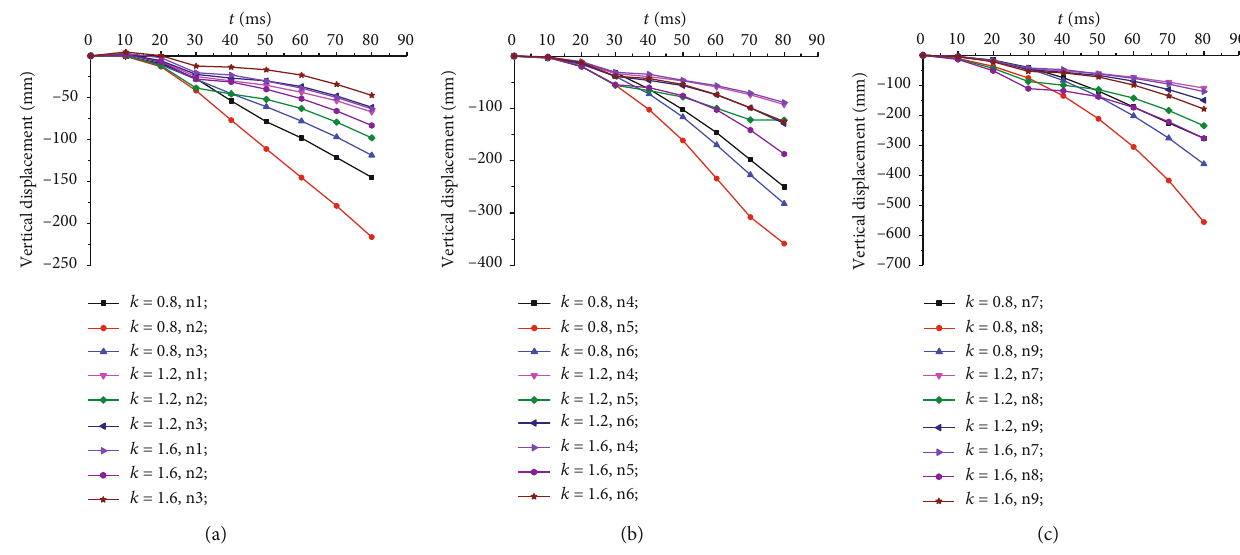
Figure 9: The vertical displacement at the 9 measuring points in the conditions of k = 0 : 8 , 1.2, and 1.6: (a) n1 ~ n3 on HL1; (b) n4 ~ n6 on HL2; (c) n7 ~ n9 on HL3.